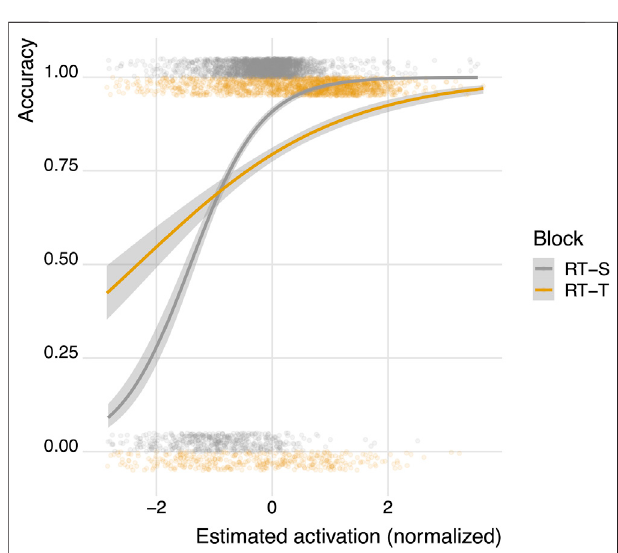
FIGURE 4 | Predicting accuracy from normalized memory activations in the RT-adaptive typing condition (RT-T) and the RT-adaptive speaking condition (RT-S). The cloud of semi-transparent points shows the empirical accuracy. These values are either 1 (correct) or 0 (incorrect) but have been offset and jittered vertically to highlight the differences between the conditions and where on the x -axis the data are